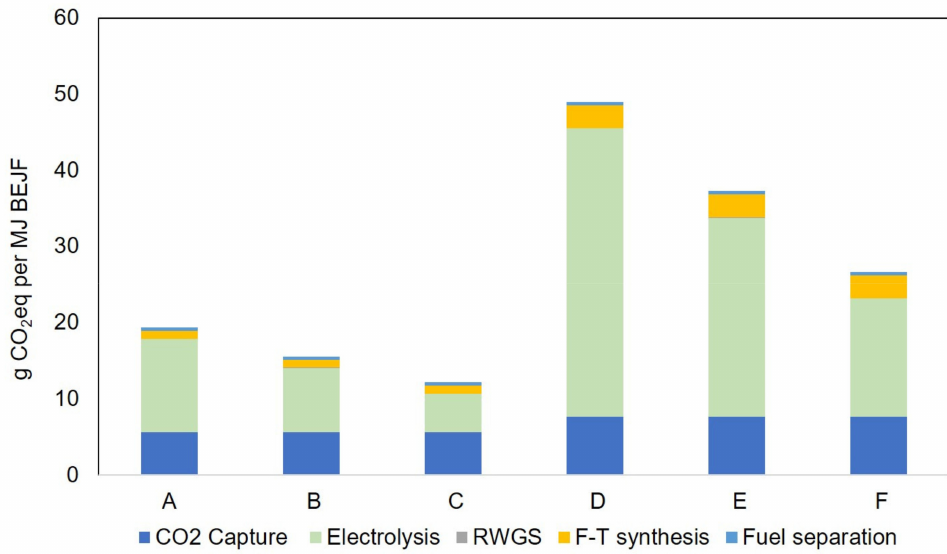
Figure 7. GHG emissions expressed as Global Warming Potential (GWP 100 years) resulting from the production of 1 MJ of BEJF. ( A ) Renewable electricity (reference scenario), ( B ) Renewable elec- tricity (heat utilization scenario), ( C ) Renewable electricity (heat and oxygen utilization scenario, economic allocation), ( D ) Average Swedish electricity mix, ( E ) Average Swedish electricity mix (heat utilization scenario), ( F ) Average Swedish electricity mix (heat and oxygen utilization scenario, economic